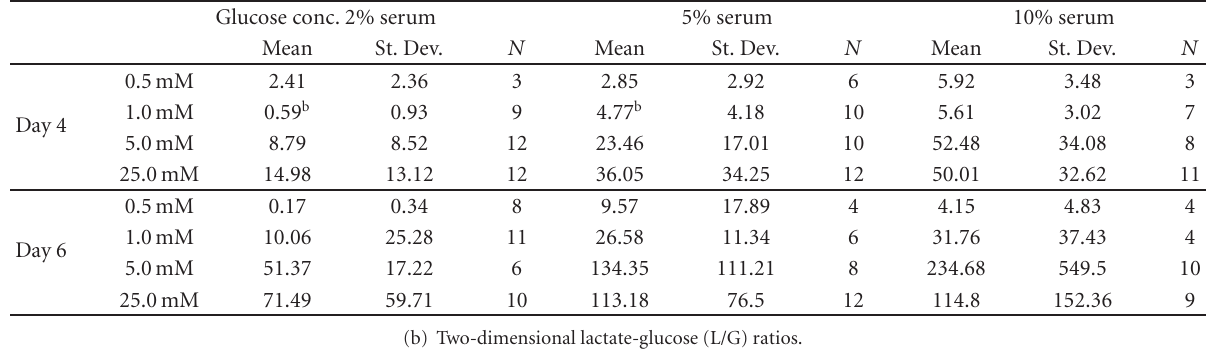
(b) Two-dimensional lactate-glucose (L/G) ratios.